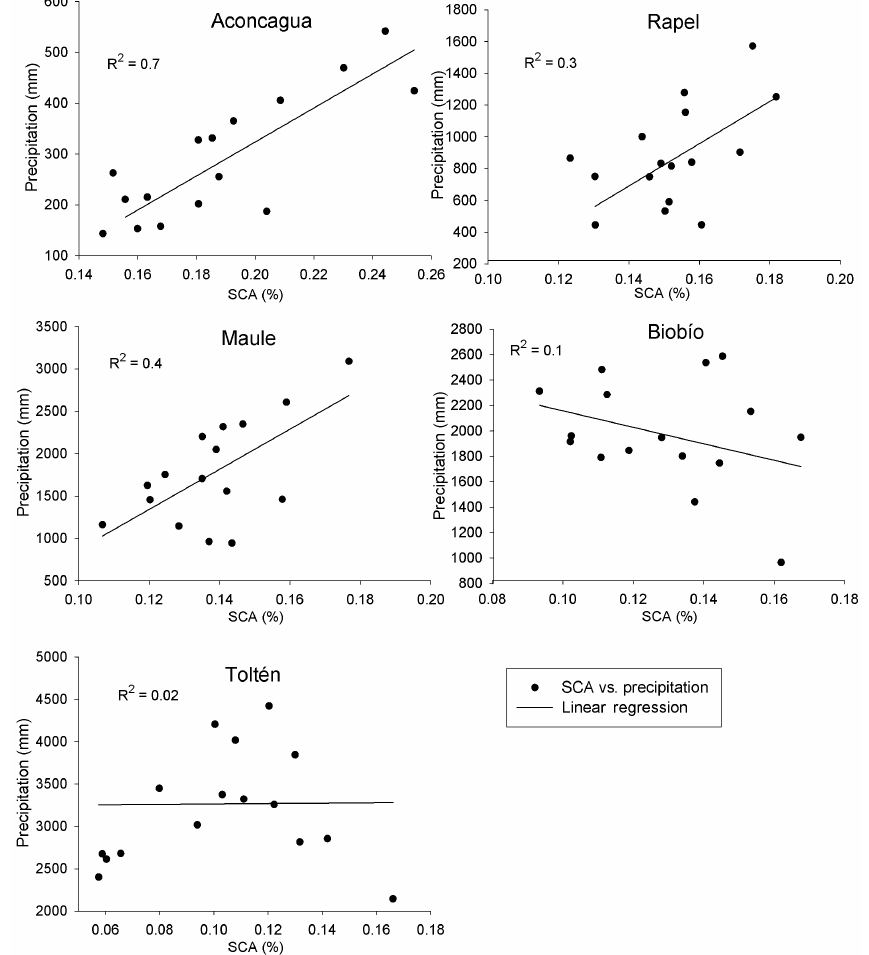
Figure 6. Relation between % of mean annual SCA and annual precipitation at Aconcagua, Rapel, Maule, Biobío and Toltén watersheds.